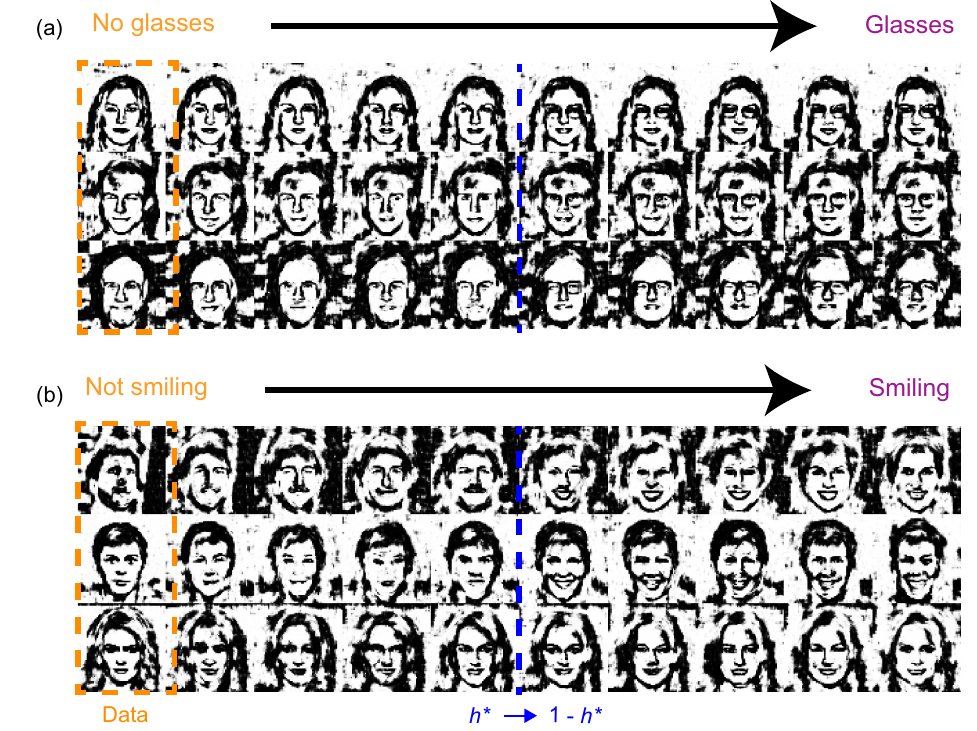
FIG. 6. Transitions between labeled classes in the CelebA dataset. RBMs are trained subject to the linear constraint acting on all but the first hidden unit denoted h ⋆ . Samples are generated conditioned on a frozen value of h ⋆ , which is flipped in the center of the Markov chain (indicated by the dashed blue lines). (a) Label corresponds to the “ eyeglasses ” attribute of CelebA. Samples are collected every three Gibbs iterations. (b) Label corresponds to the “ smiling ” attribute of CelebA. Samples are collected every five Gibbs